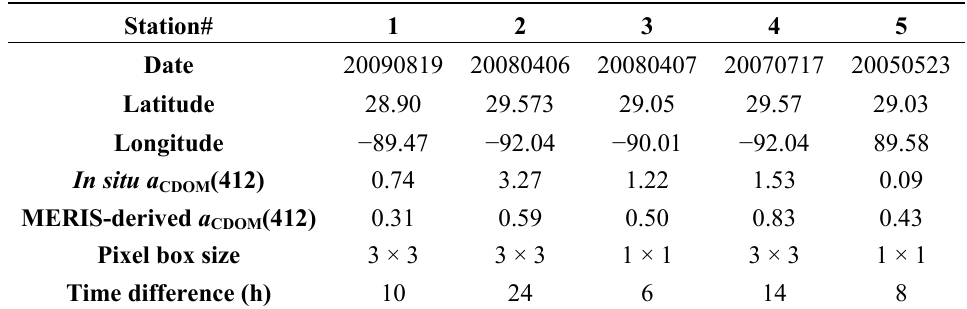
Table 9. Summary of outlier stations excluded from CDOM matchup comparison for